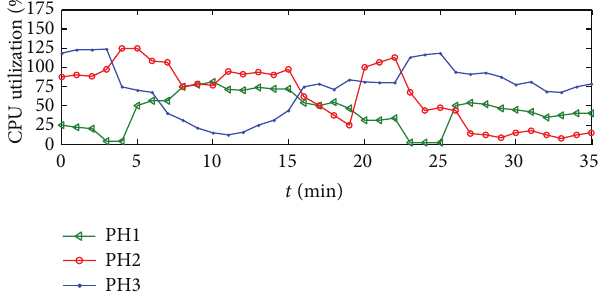
Figure 5: The sum of CPU percentage usage of VMs on each